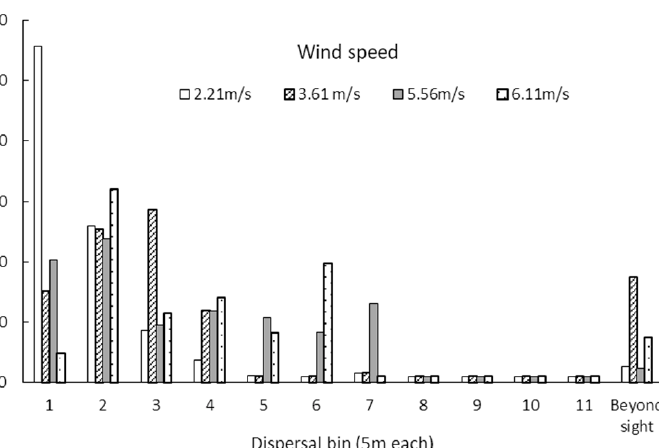
Figure 4. Percentage of seeds deposited within progressive dispersal intervals at four wind speeds. At a wind speed of 3.61 m/s, a relatively large proportion of seeds achieved long-distance